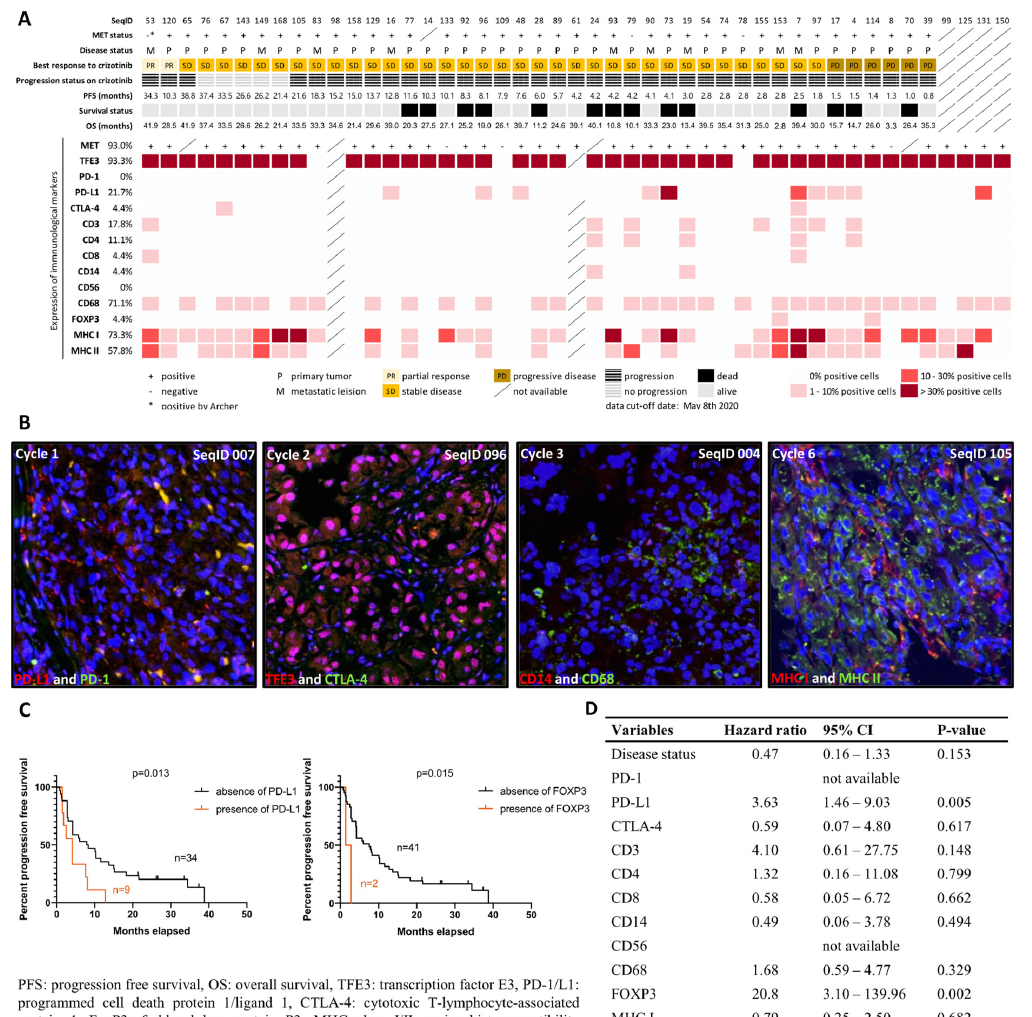
Figure 1. Overview and representative images for characterization of tumor microenvironment in alveolar soft part sarcoma. ( A ) The heatmap demonstrates an overview of the expression of the immunocompetent components in the tumor, tested across 47 cases on a tissue microarray. The MET expression was determined by immunohistochemical positivity. The expression level was determined by the percentage of immunopositive cells among cores per case, and the mean was recorded as the final result. A MET-negative case labeled with * was subjected to the post hoc Archer analysis and identified as a TFE3 -rearranged tumor. ( B ) Representative images show immunofluorescence- stained tissue in different cycles of the MILAN procedure, with different markers. Images were digitally scanned using 200-fold magnification. The blue color showed 4 (cid:48) ,6-diamidino-2-phenylindole (DAPI) staining and represented nucleated cells. Membrane expression of programmed cell death ligand 1 (red) was detected in a small proportion of tumor cells in the first cycle; no expression for programmed cell death 1 (green) was observed. In the second cycle, pink color on merged images indicated nuclear localization of transcription factor E3 (red), but no green fluorescence for cytotoxic T lymphocyte-associated protein 4 was detected. In the third cycle, membrane expression of CD14 (red) and CD68 (green) were detected. The presence of major histocompatibility complex class I (red) and II (green) was demonstrated in the sixth cycle. ( C ) Kaplan–Meier estimate of progression-free survival in ASPS patients with and without the expression of immunological markers; p -value is shown for the presence vs. absence of immunological markers. ( D ) Univariate Cox regression analysis of immunological molecules upon progression-free